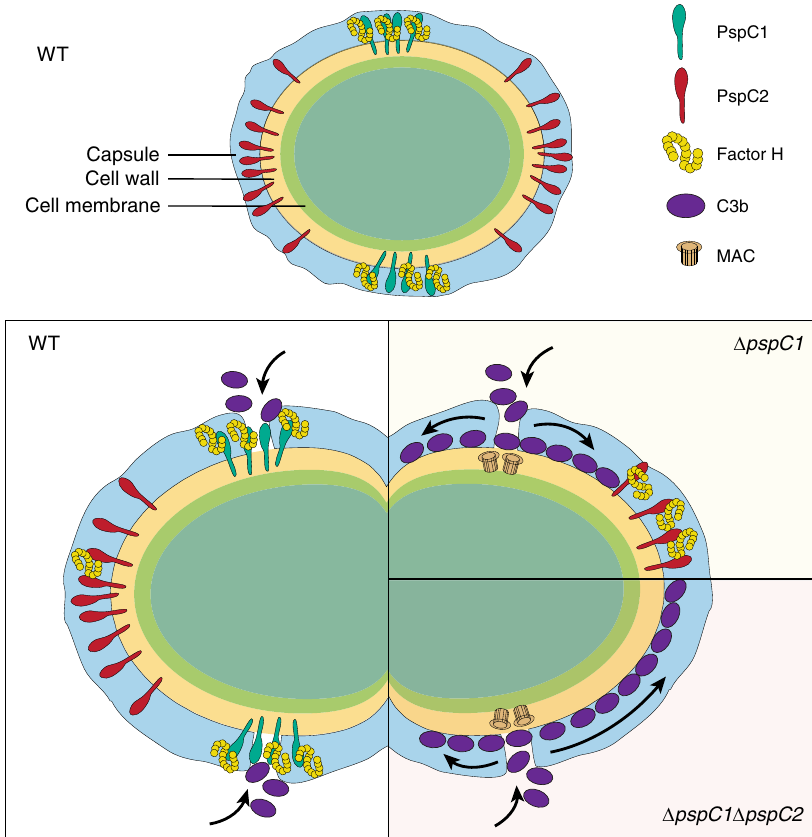
Fig. 8 Proposed roles for PspC1 and PspC2 in complement deposition and ampli fi cation. In wild type (WT) bacteria, PspC1 is presented at the division sites where it recruits human FH. In contrast, PspC2 is presented at the bacterial poles mediating bacterial adhesion to lung epithelial cells. Single cocci (top panel) are more resistant to complement deposition in comparison to diplococci (lower panel) or chains with the latter showing areas of little or no capsule close to the division septum, a site serving as entry port for complement deposition. In the absence of PspC1, FH can bind to PspC2 at the poles and deposited C3b can amplify laterally below the capsular layer except for to the poles, which are protected by PspC2, leading to increased opsonophagocytosis. When both PspC1 and PspC2 are lacking, bacteria are fully covered with C3b including the Antibody production directed to PspC2 . Recombinant PspC2 protein lacking the (wt/vol) dextrose and serum (DS)-containing medium. Unless otherwise stated, LPxTG motif and the fi rst 37 aa, which constitute a signal peptide region, was strains were grown to mid-log phase (OD620, 0.3 – 0.4). expressed and puri fi ed in E. coli (see above). Puri fi ed PspC2 was sent to Innovagen AB for rabbit immunization and production of polyclonal antibodies. Polyclonal Mutants of Streptococcus pneumoniae . All deletion mutants were constructed using polymerase chain reaction (PCR) ligation mutagenesis. PCR amplicons of fragments upstream and downstream of the target gene and the Erythromycin (ermB), kanamycin (kan) cassette, or tetracycline (tet) cassette were generated with speci fi c primer pairs containing overlapping regions. The ermB cassette, kan cas- sette, or tet cassette was fi rst fused to the upstream fragment and then the downstream fragment was added by PCR. If ampli fi cation led to multiple PCR products, the PCR fragment with the correct size was gel-puri fi ed after agarose gel electrophoresis. Finally, the fusion PCR product was used to transform S. pneu- moniae . Mutants were selected on blood agar plates containing erythromycin (1 μ g/ mL), kanamycin (400 μ g/mL) or both. Tetracycline resistance was used to create capsule deletion mutant. The correct insertion was con fi rmed by PCR and sequencing. The primers used for each mutant are stated in Supplementary Table 3. Expression and puri fi cation of 6×His-PspC . PspC (D39), PspC1 (BHN418), and PspC2 (BHN418) were cloned into the NdeI/XhoI or NdeI/BamHI restriction site of pET28a vector (Novagen) and transformed into E. coli Rosetta (DE3) cells (Novagen). Recombinant protein was expressed as 6×His-tagged N-terminal fusion protein in logarithmically growing cultures with IPTG (Sigma). Bacteria were resuspended in buffer containing 50 mM Tris·HCl, 50 mM NaCl, and 5% glycerol and disrupted using a Stansted cell disrupter. 6×His-PspC was puri fi ed from the soluble fraction by af fi nity chromatography by using Ni-NTA His Bind resin (Novagen) according to the manufacturer ’ s guidelines. Puri fi ed 6×His-PspC2 was incubated rotating with 100 U/mL thrombin (Sigma) for 2h at room temperature. To remove uncut protein and His-tag, PspC2 was passed over Ni-NTA resin and further puri fi ed by size exclusion chromatography by using Superdex 75 gel fi ltration columns (GE Healthcare). Purity was assessed by electrophoresis on a SDS/PAGE. body (Life Technologies, A16143, 1:200). Each incubation step was followed by